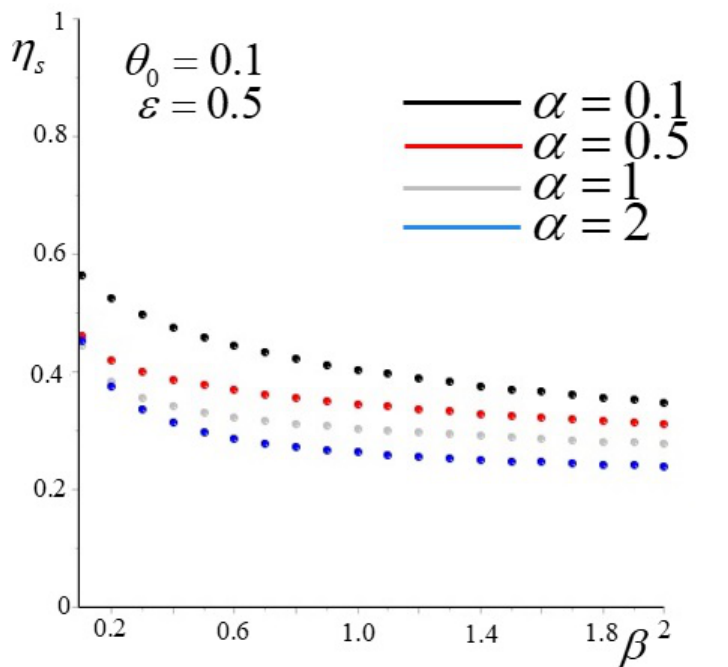
Figure 5. The plot of efficiency η s as a function of β for four different values of α and for θ 0 = 0.1.